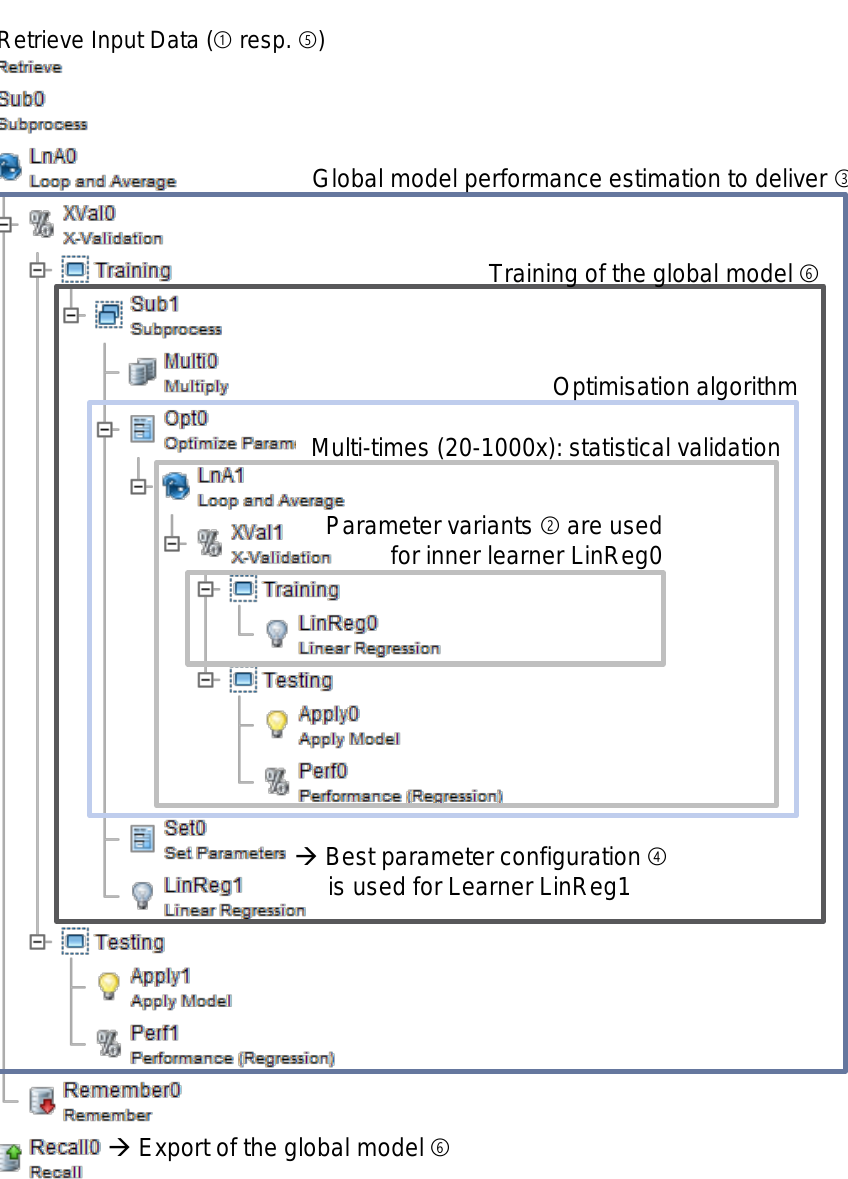
Figure 9. The ROPE process as a nested data mining scheme in RapidMiner ® for a linear regression. For a different algorithm, e.g., regression tree (like M5P), the inner operators LinReg0 and LinReg1 are